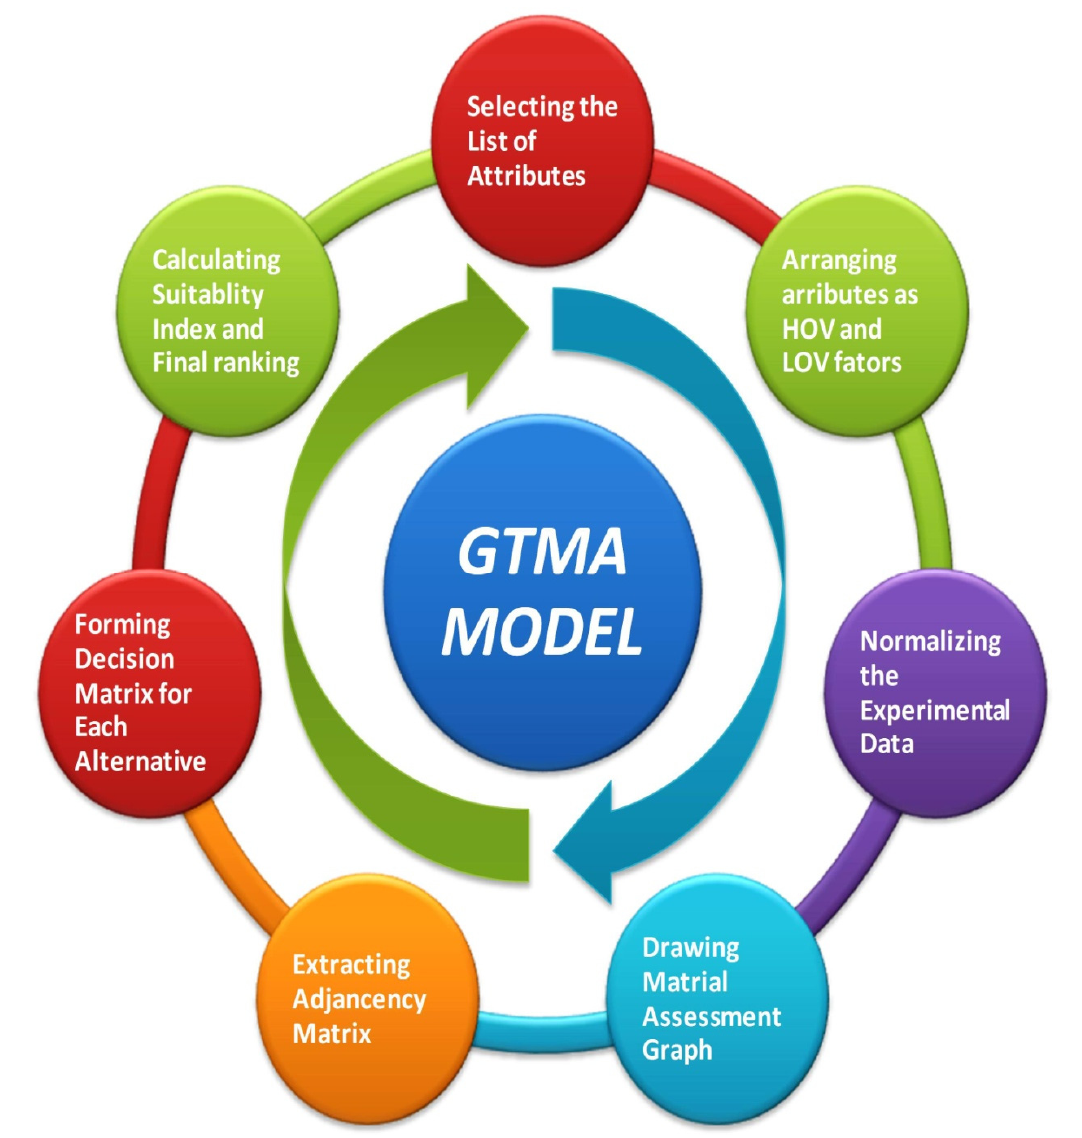
Figure 3. Flow chart representing the stepwise applicability of the proposed GTMA model.